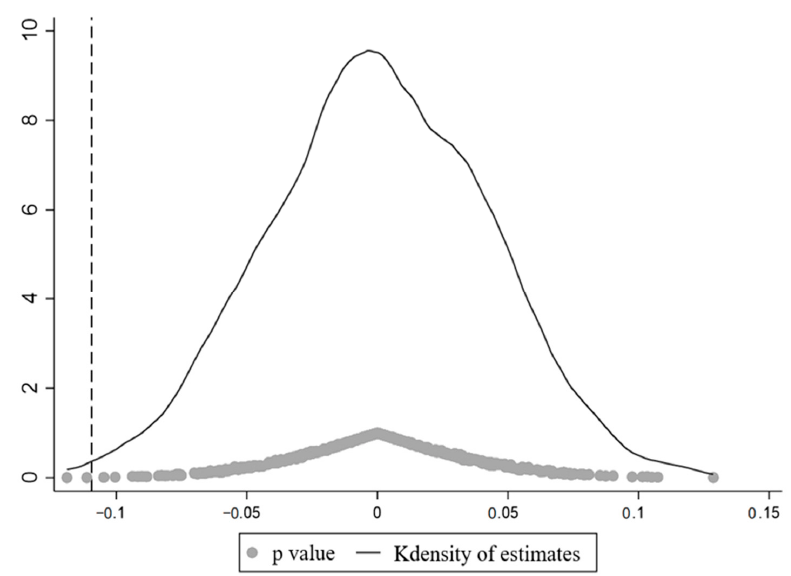
Figure 8. Results of the placebo test of OLS.